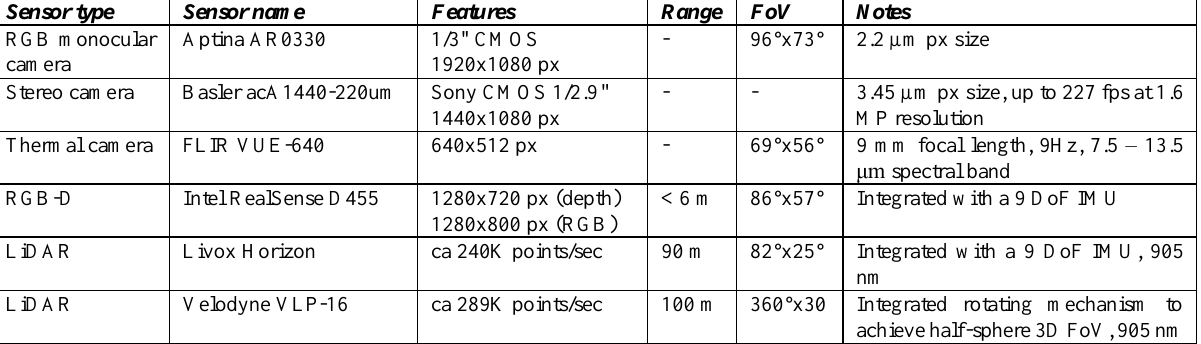
Table 1: Specifications of the six sensors mounted on the robot.